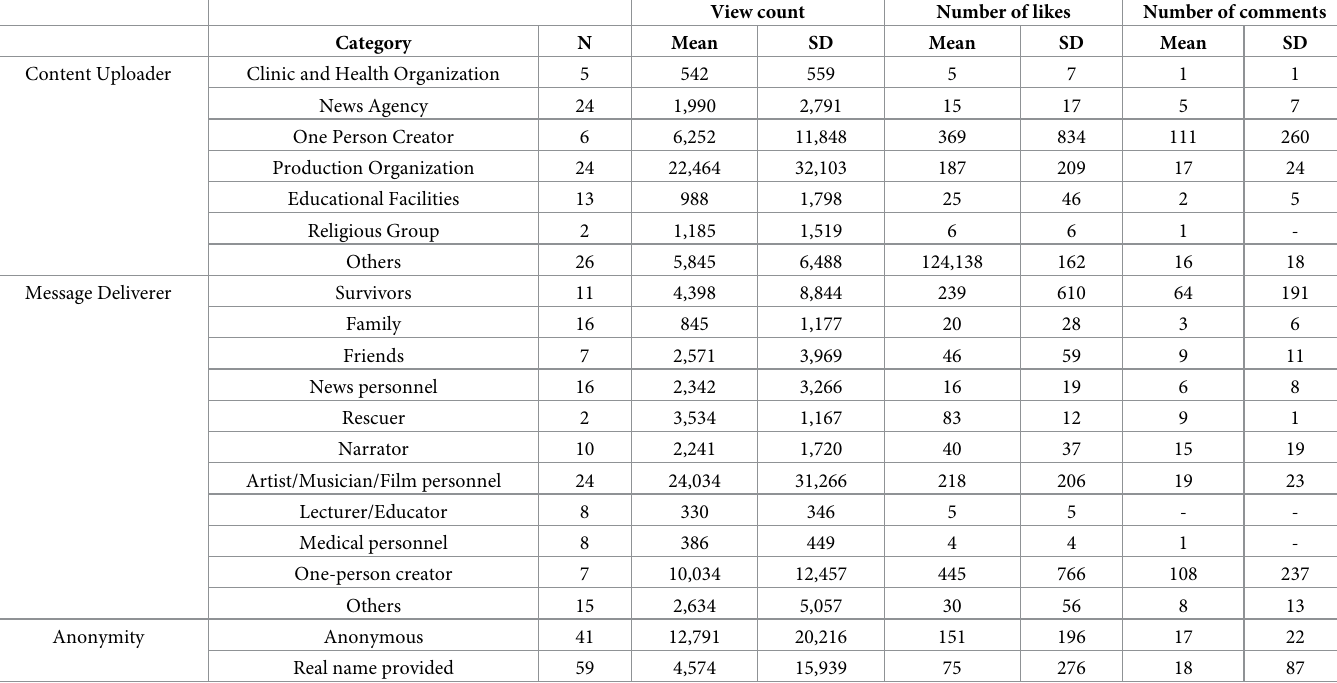
Table 1. Descriptive statistics for content deliverer characteristics (who).